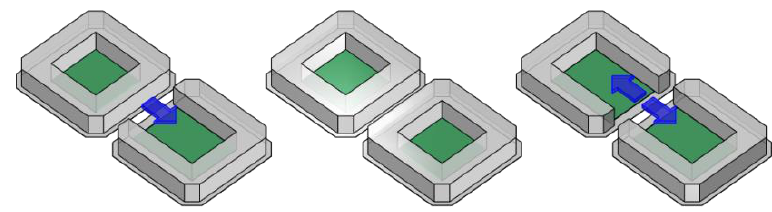
Figure 5. Connectivity possibilities between the blocks. In order (value): block to opening (0), block to block (1), and opening to opening (2). Courtyard connectivity is ranked to encourage larger courtyards between blocks and generate wide fields of view. A low ranking discourages blocks that have courtyards with one-sided access.